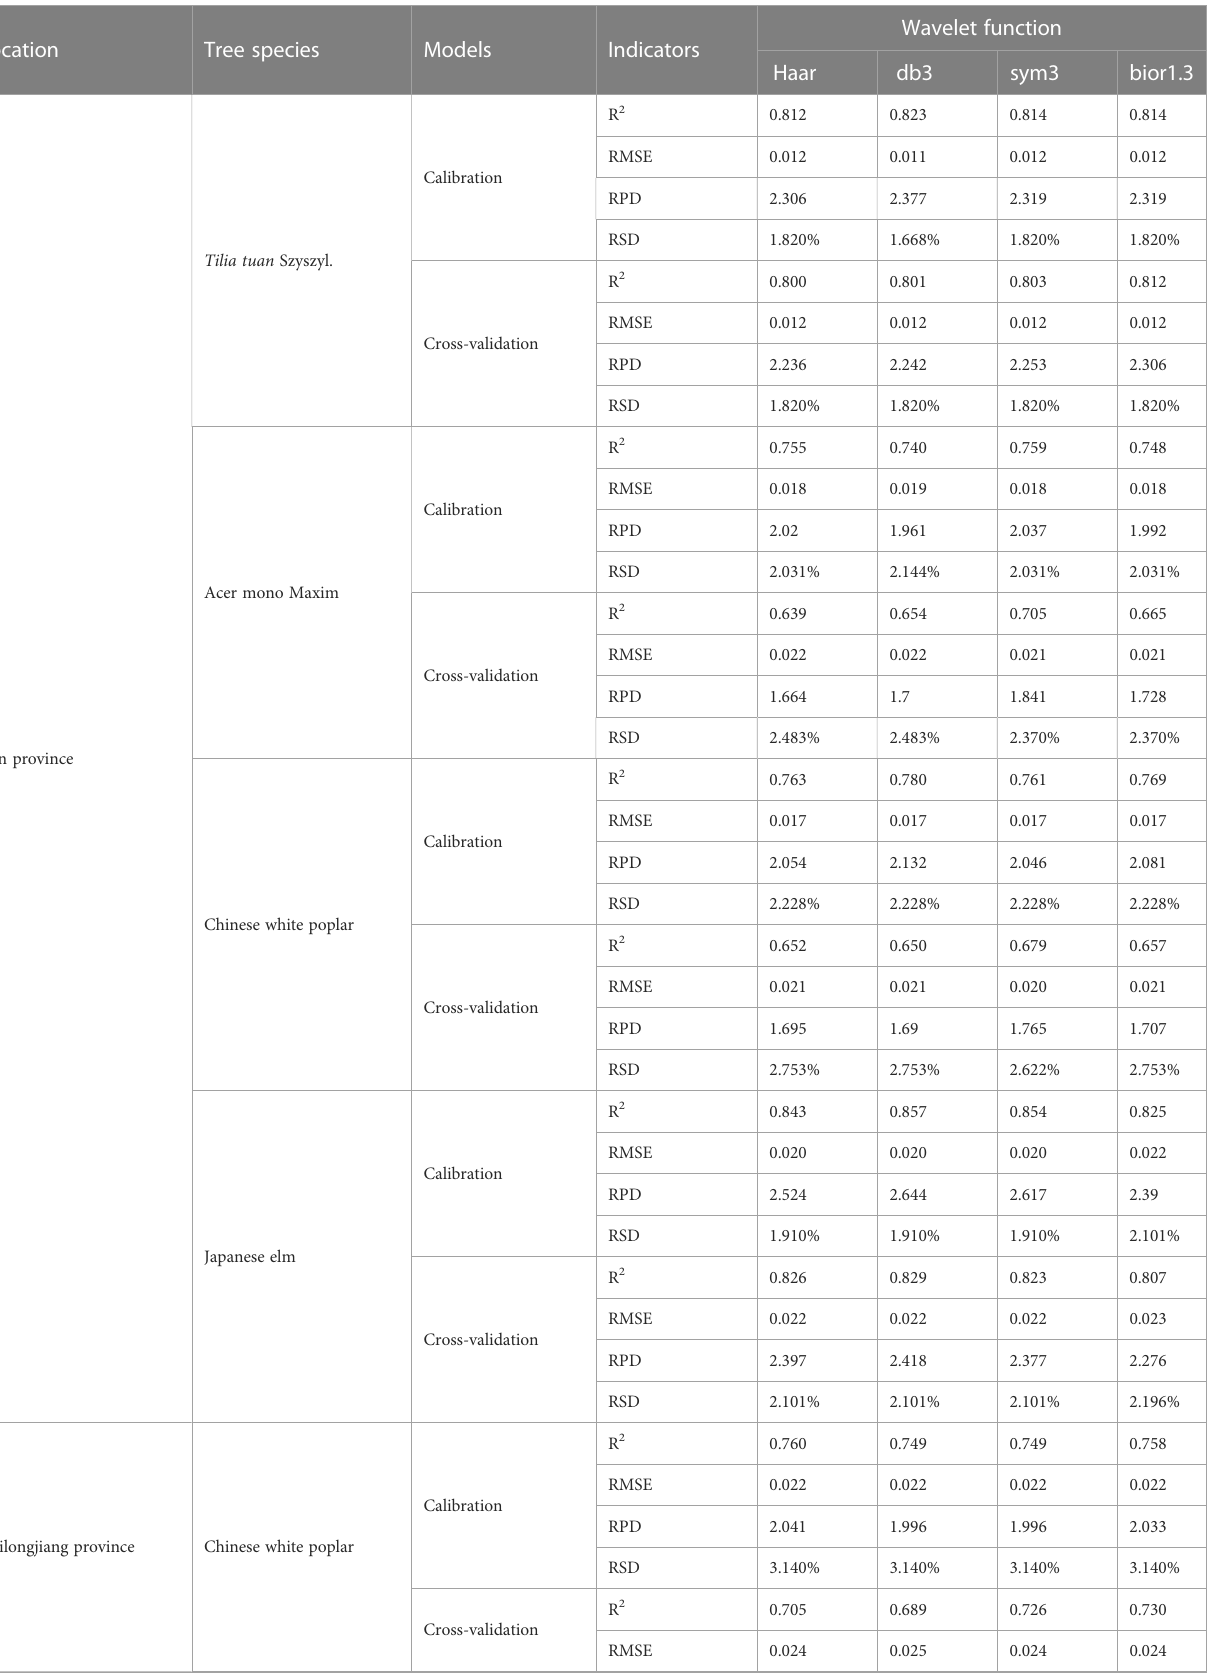
TABLE 1 The PLS model results of wood density with different wavelet functions.